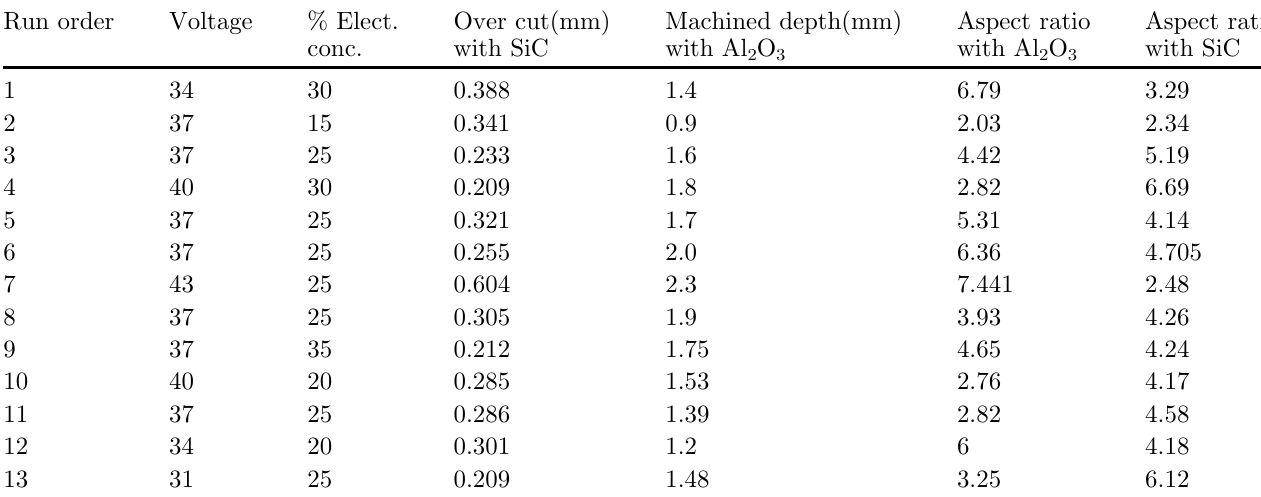
Table 2. Interaction effect of parameters. Run order Voltage % Elect.